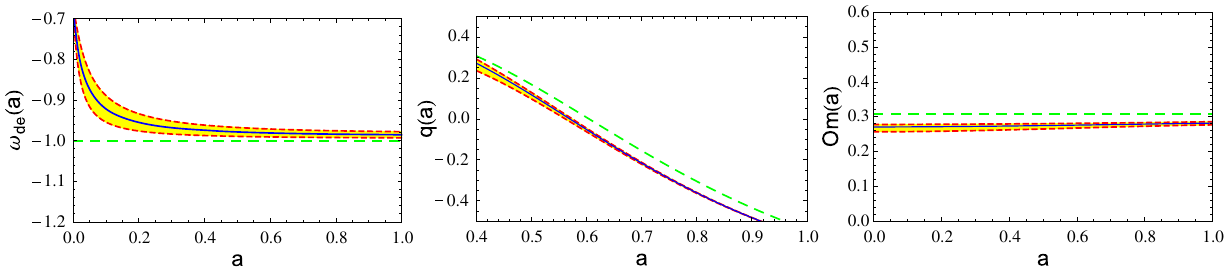
Fig. 6 From left to right , we exhibit the relations between the scale factor a and the DE EoS ω( a ) , deceleration parameter q ( a ) and Om ( a ) diagnostic, respectively. The solid ( blue ) lines and long-dashed ( green ) lines correspond to the pressure-parametrization UDF model Using (cid:12) m 0 = 0 . 308 [62] for the flat (cid:3) CDM model